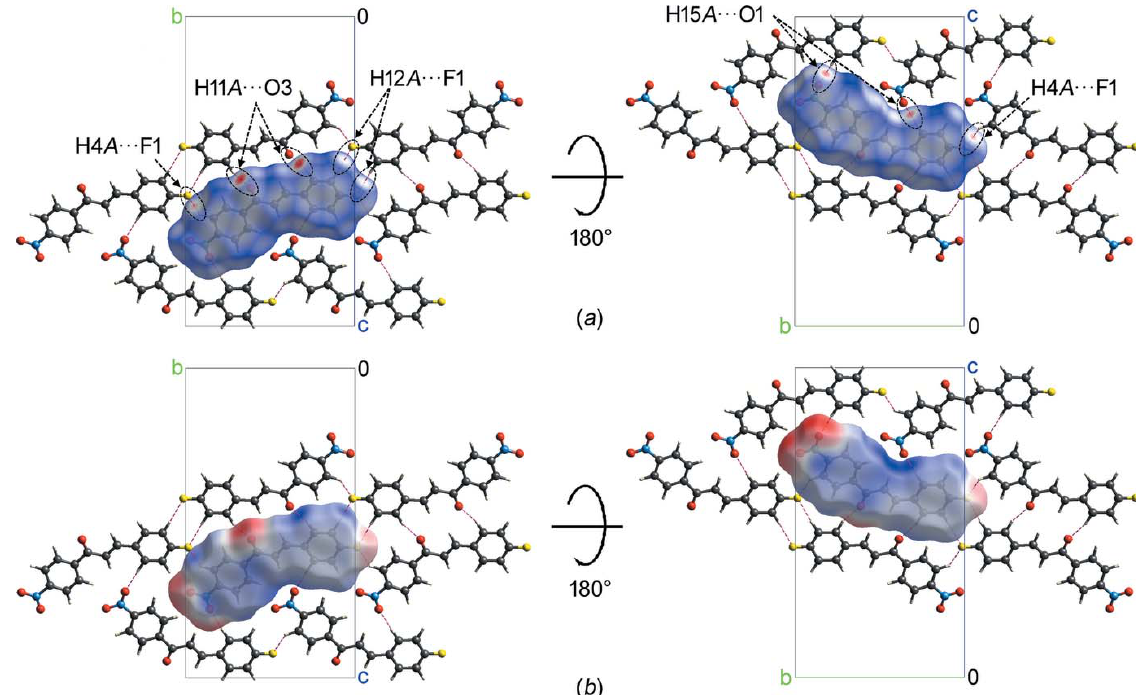
Figure 4 The Hirshfeld surfaces mapped with ( a ) d norm and ( b ) electrostatic potential for the central molecule of the title compound surrounded by six neighbouring molecules.